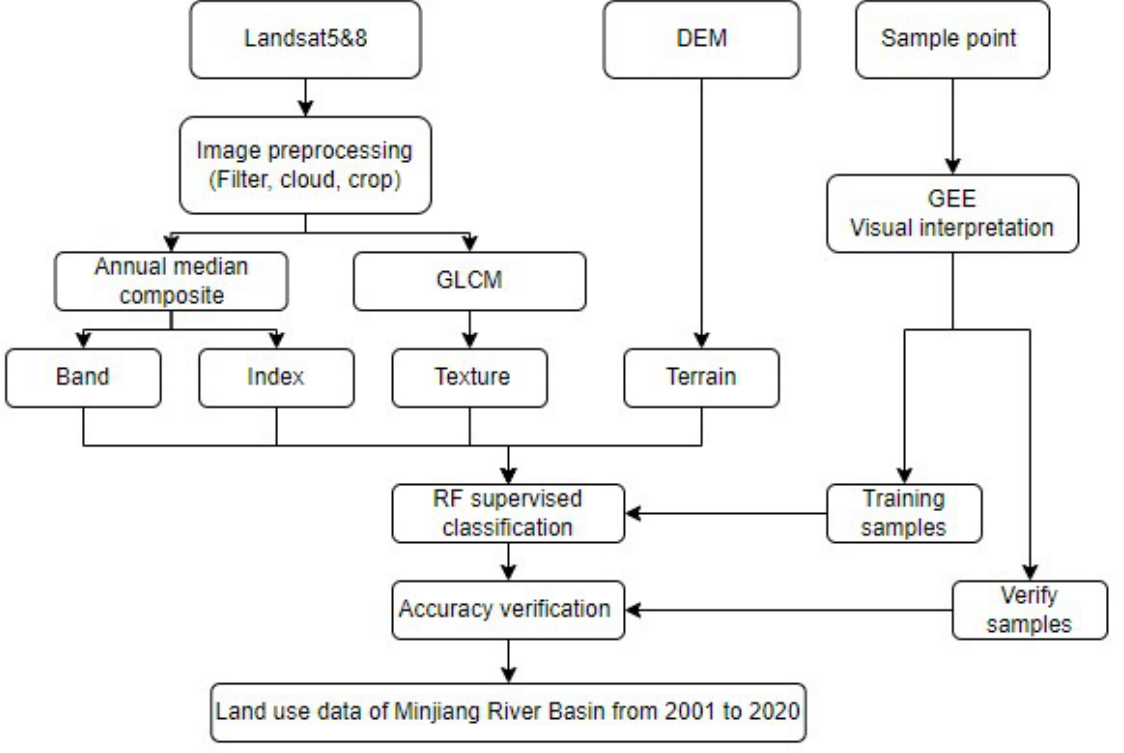
Figure 2. Flow chart of land use classification.